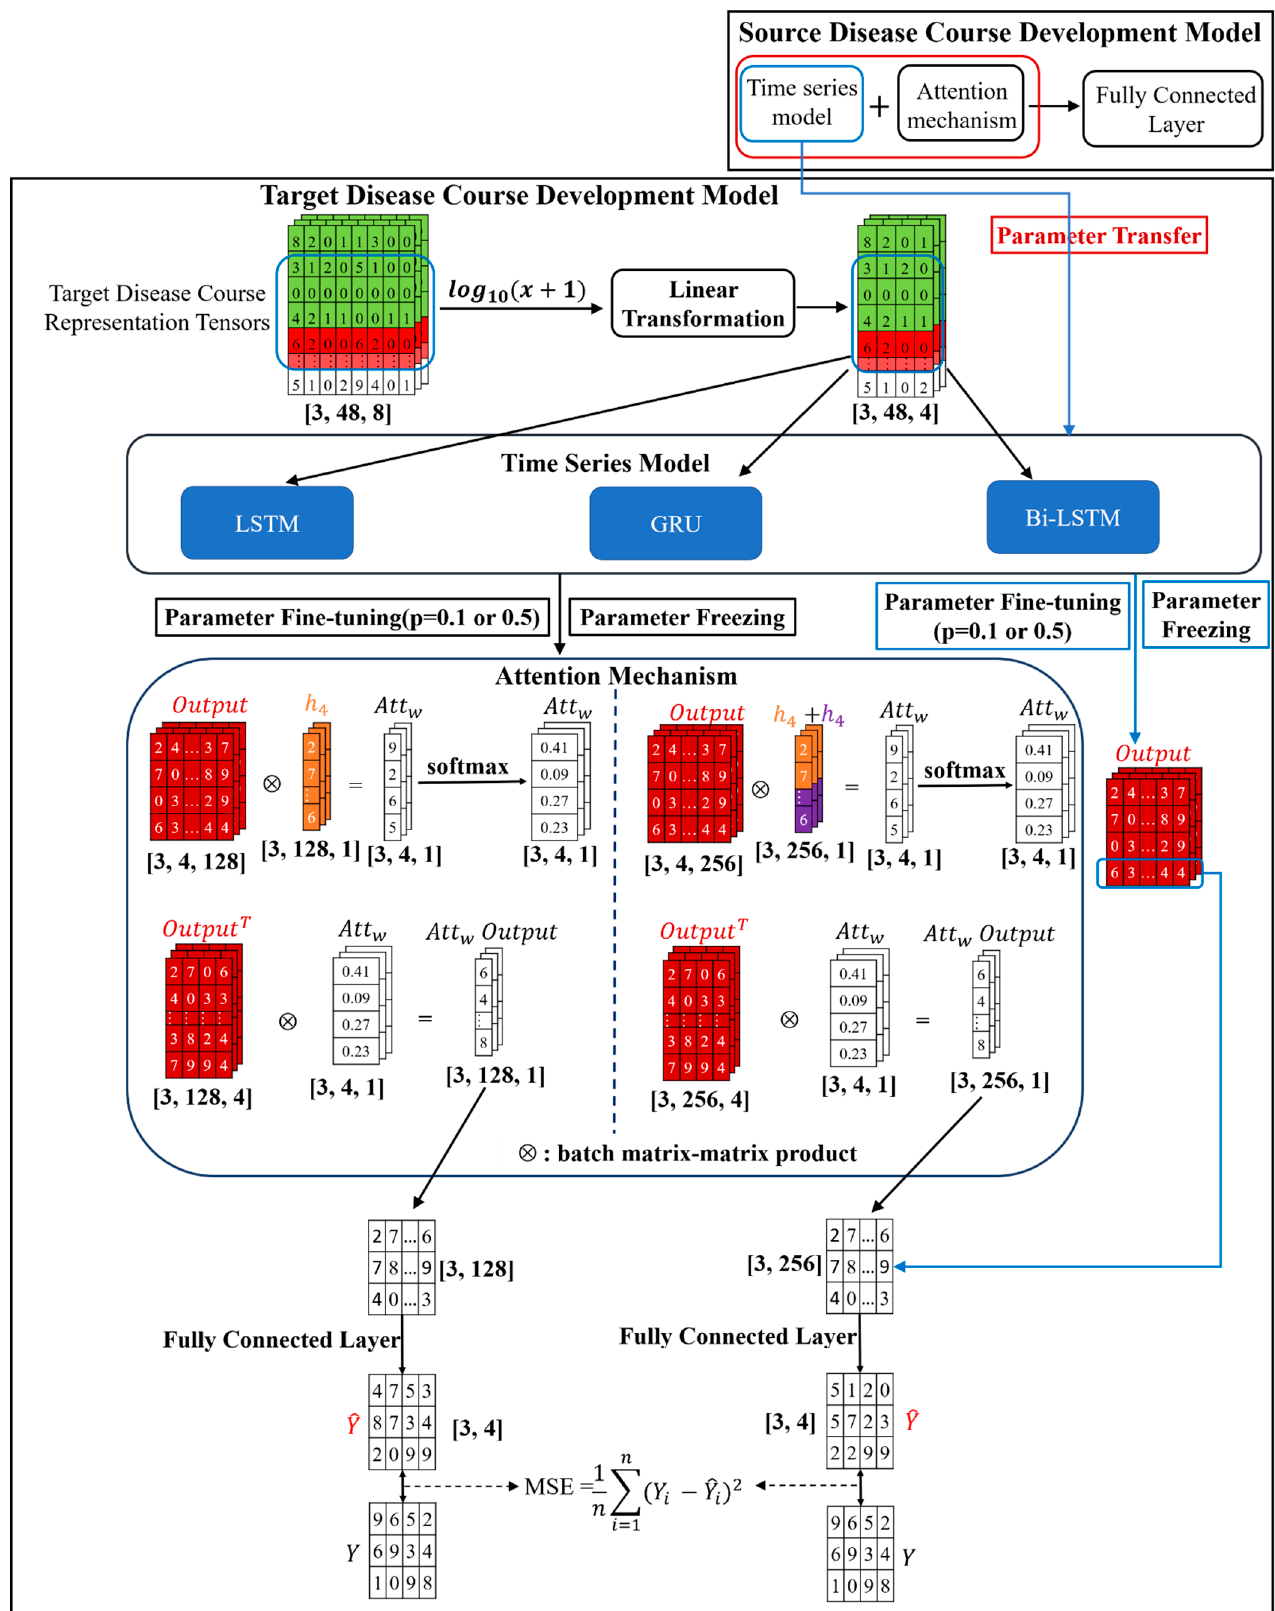
Figure 8. Prediction Model of Target Disease Course Development.